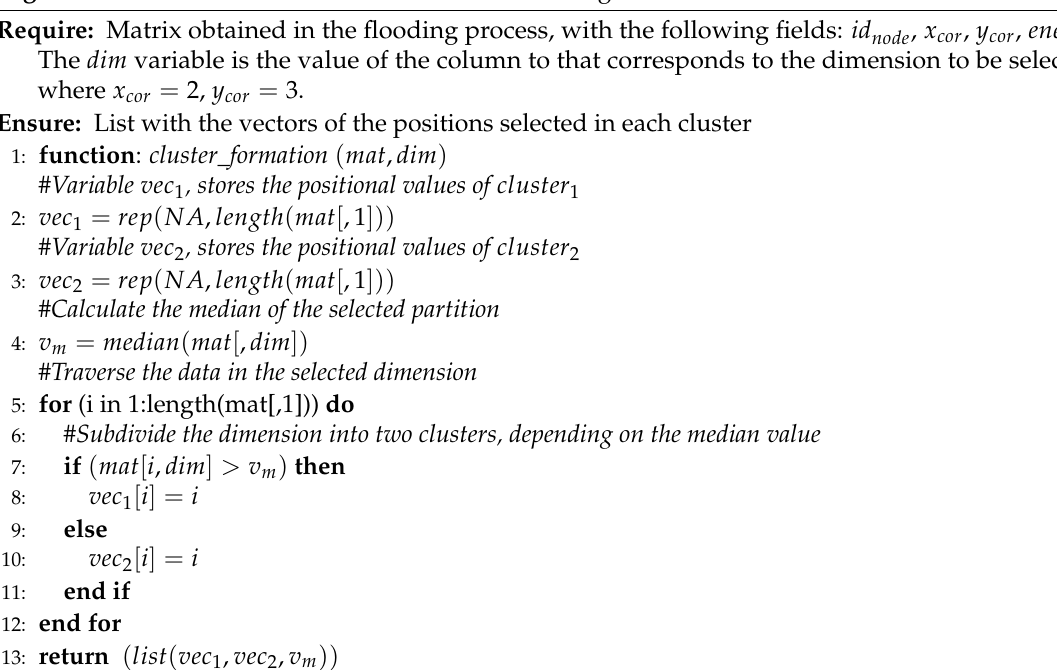
Algorithm 2 Cluster formation based on the k-d tree